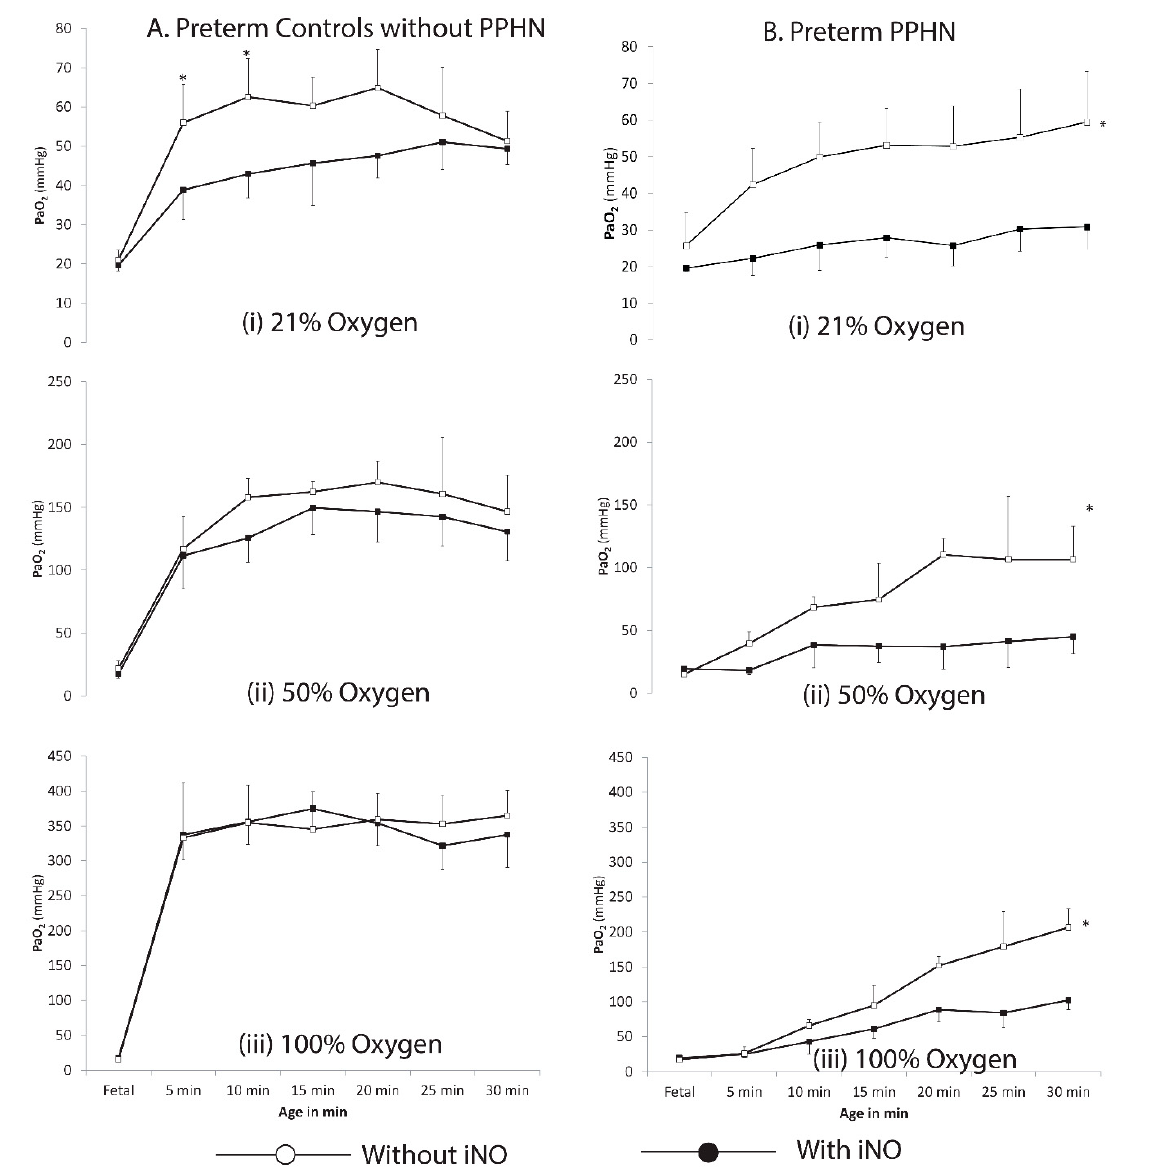
Figure 2. Changes in oxygenation with inhaled nitric oxide (iNO): PaO 2 in the first 30 min of life in ( A ) preterm lambs without persistent pulmonary hypertension of the newborn (PPHN) with exposure to 21, 50 and 100% oxygen with (open squares) and without iNO at 20 ppm (solid squares). ( B ) PaO 2 in the first 30 min of life in preterm lambs with PPHN on exposure to 21, 50 and 100% oxygen with (open squares)and without iNO (solid squares) at 20 ppm. * p < 0.05 compared to PaO 2 without iNO.